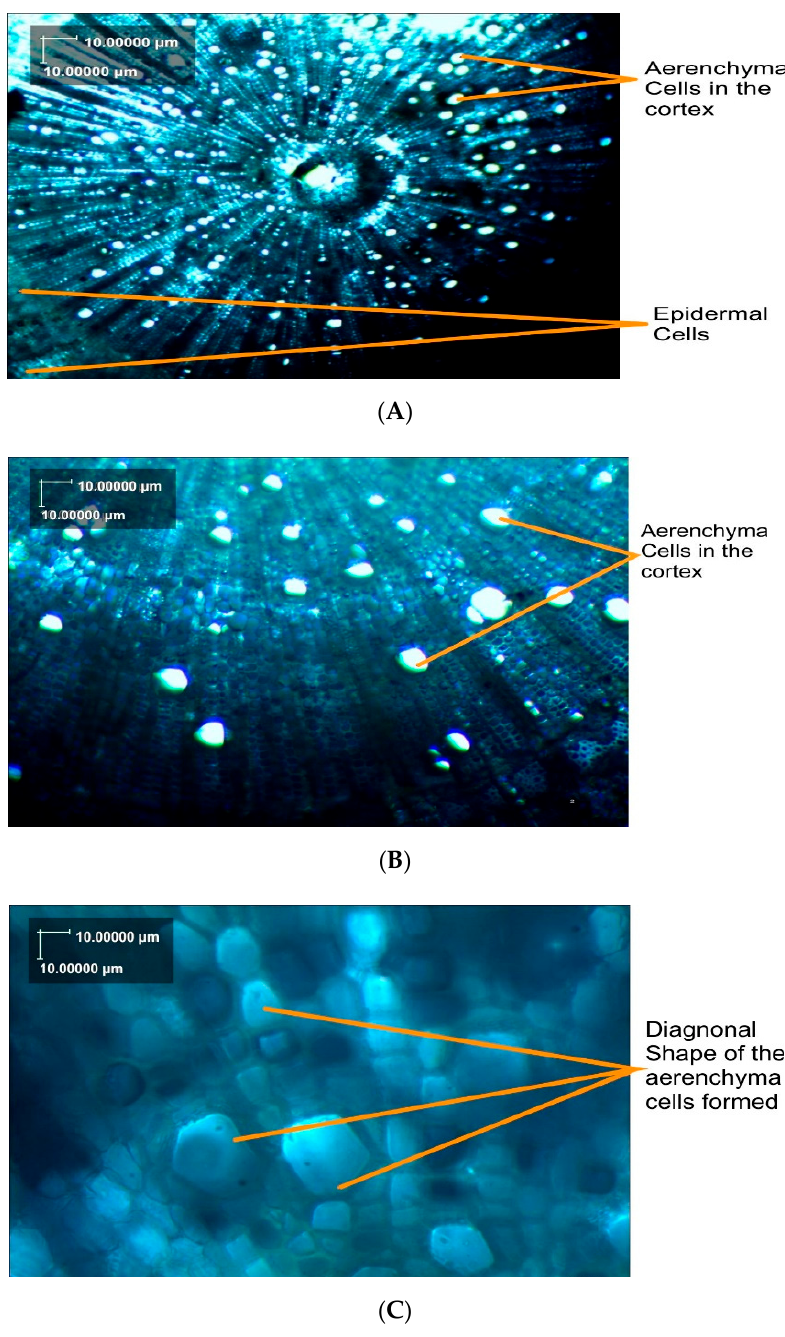
Figure 4. Root sections of okra plants grown from different concentrations of NaN 3 -treated seeds show aerenchyma cells formed under two-week waterlogging conditions. ( A ) 0% NaN 3 , ( B ) 0.02% NaN 3 , ( C ) 0.05% NaN 3 .